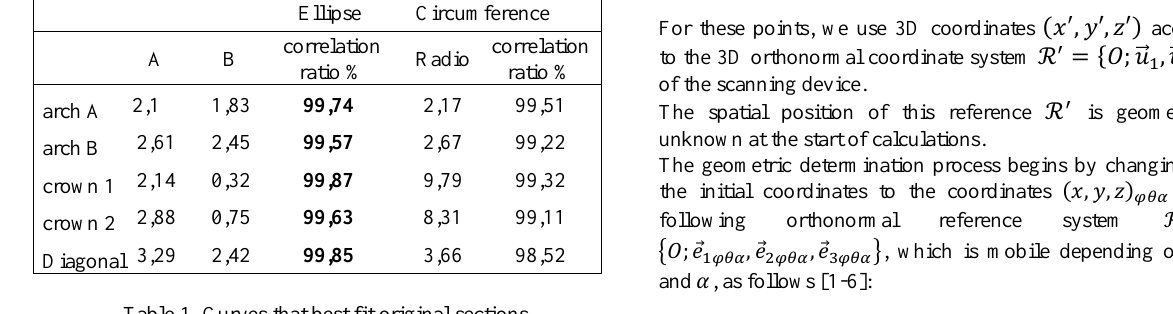
Table 1. Curves that best fit original sections